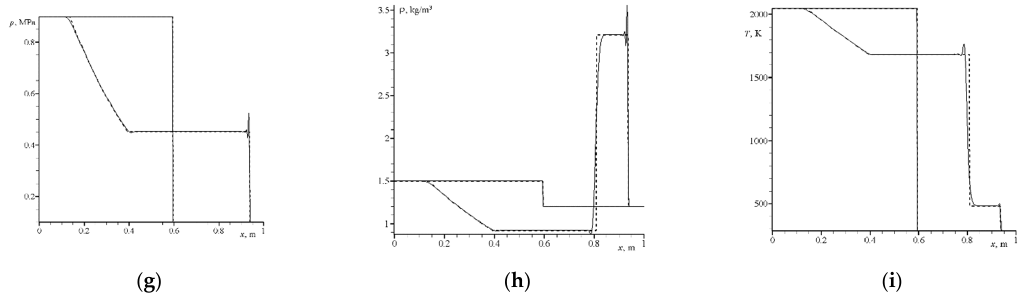
Figure A1. Calculation results for discontinuity decay in p ( x ) , ρ ( x ) -, and T ( x ) -distributions at the times t = 0 and t = 5 · 10 − 4 s : ( a – c ) calculation performed using the first-order scheme; ( d – f ) calculation performed using the Lax–Wendroff scheme; ( g – i ) calculation performed using scheme (A15) with η = 9. 2. Numerical scheme for 2D calculation on an irregular difference grid.